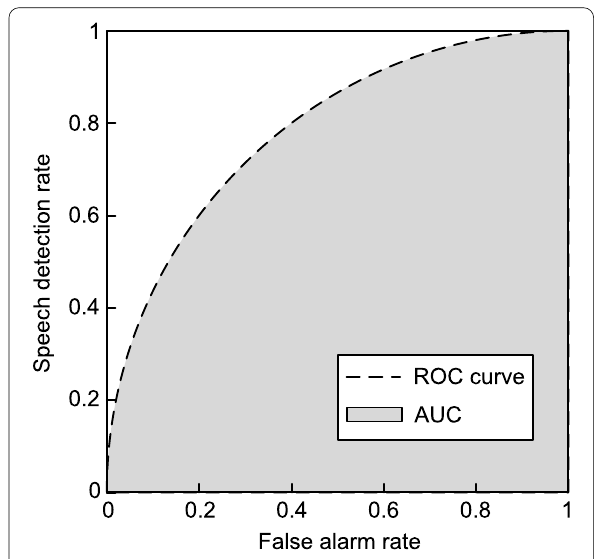
Fig. 1 Illustration of ROC curve and